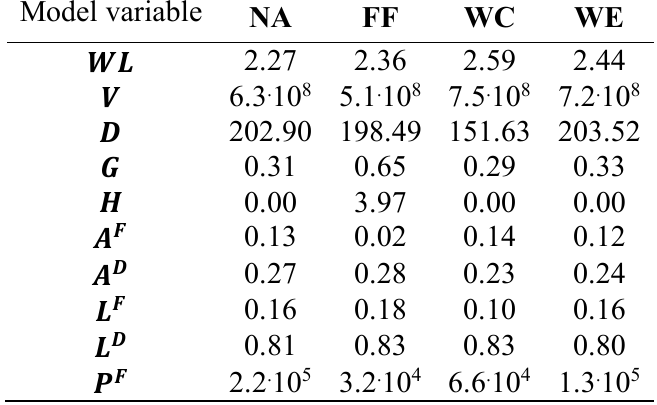
Table A2. Average values of different model variables obtained for the synthetic experiment additional scenario #1 with dam construction and four water management strategies (NA: No Actions; FF: Fighting Floods; WC: Water Conservation; WE: Water Exploitation)